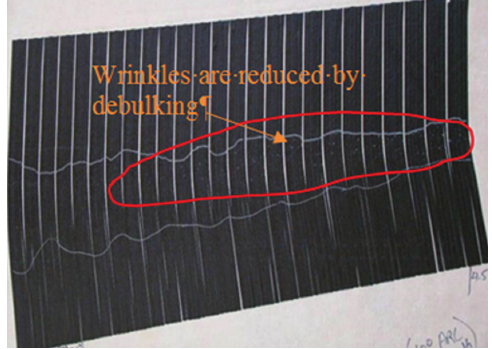
Figure 12 After 15 min debulking (case 2: θ = 10 ° , ply 2, laid down at 10.7 m/min).